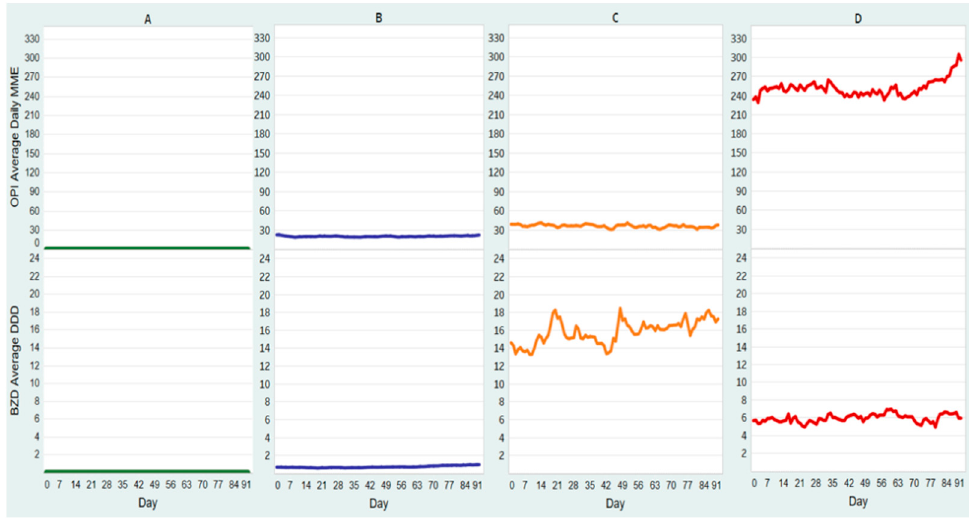
Figure 7. Multi-trajectory patterns of medical